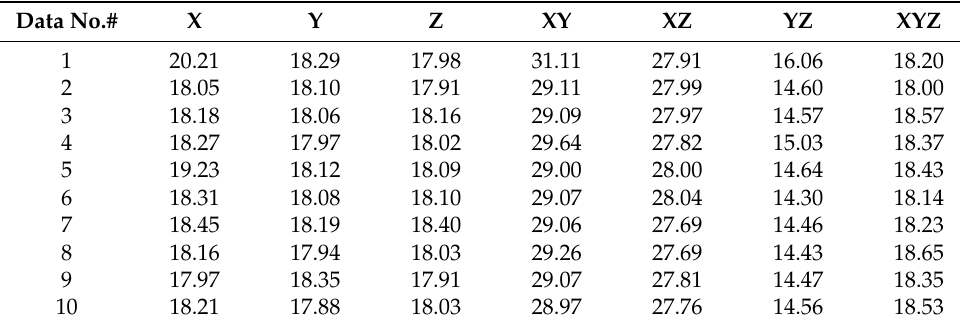
Table 7. CNN summary of ‘training time’ (sec).